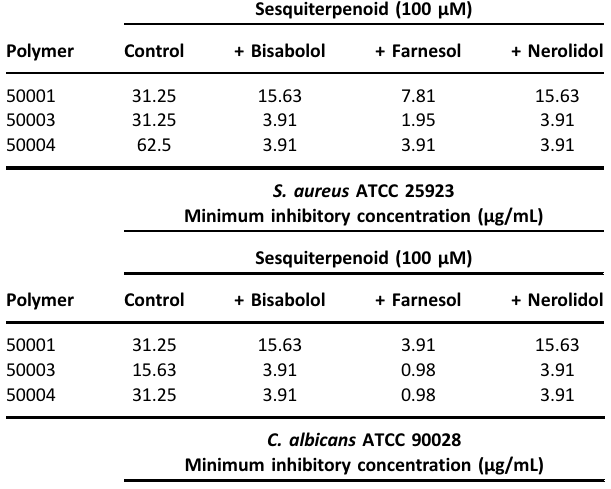
Table 2. Enhancement of E. coli ATCC 25922 inactivation